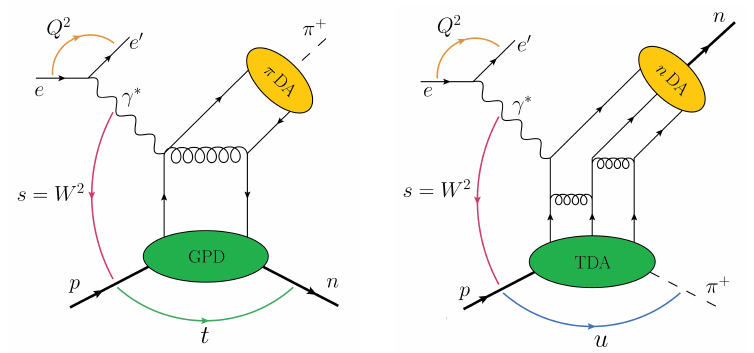
Figure 1: Left: Diagram of the GPD mechanism in very forward kinematics ( − t / Q 2 (cid:28) 1). Right: Diagram of the TDA mechanism in very backward kinemat- ics ( − u / Q 2 (cid:28) 1). [ 13